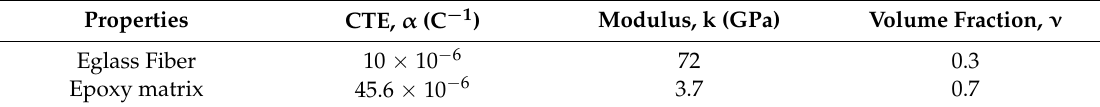
Figure 21. Typical stress-strain response of polyester synthetic surfacing veil/epoxy laminate. Table 8. Properties of epoxy matrix and E-glass fiber used in Turner’s equation.